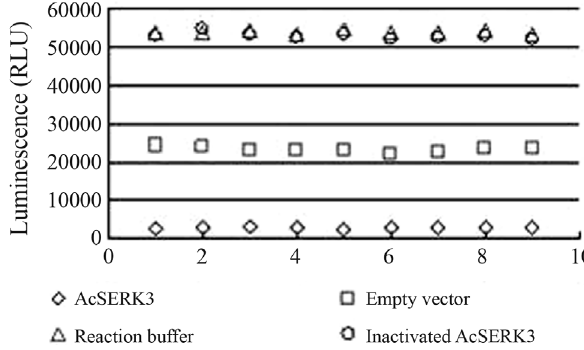
Figure 4 - Autophosphorylation of AcSERK3 fusion protein. The lumi- nescence was inversely correlated with the amount of kinase activity. AcSERK3 - purified His6-AcSERK3 fusion protein, empty vector - puri- fied product of E. coli cells containing the pET-30a vector, reaction buffer - reaction buffer without protein, inactivated AcSERK3 - AcSERK3 pro- tein after boiling for 25 min. All phosphorylation assays involved incuba- tion with 2.5 x 10 -3 (cid:3) mol (cid:4) ATP. RLU - relative luminescence